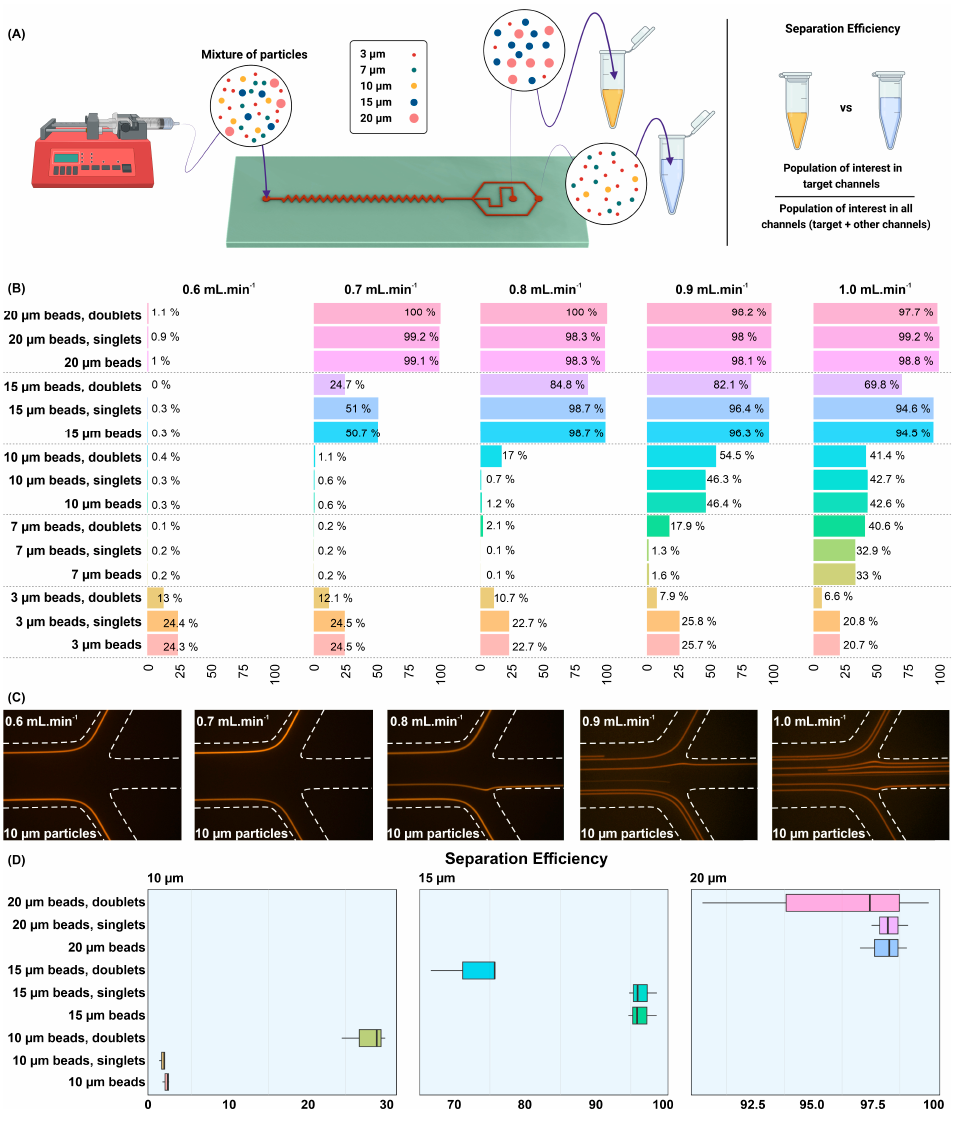
Figure 3. Result from a flow rate titration on a 3D printed inertial focusing device. ( A ) Shows the system setup and a visual representation of how samples are collected, and calculations of SE were made for the central channel, which, in this case, is designed to enrich cells/particles that are above ~12 um. ( B ) Shows the SE as calculated using the gating method shown in Figure 2 for all bead populations tested at different flow rates. Shown here, also, are the SE values for the singlet and doublet events for each bead size. ( C ) Shows the results from a traditional fluorescence trace exper- iment. These results clearly indicated that (i) the result from each method is similar, the fluorescent trace analysis only shows performance at a single point in time, there is no way to quantify the results based on fluorescent streak analysis, and it is not possible to analyze the behavior of doublets or cluster using fluorescent imaging. ( D ) Shows the reproducibility of our method to calculate SE over three independent experiments.